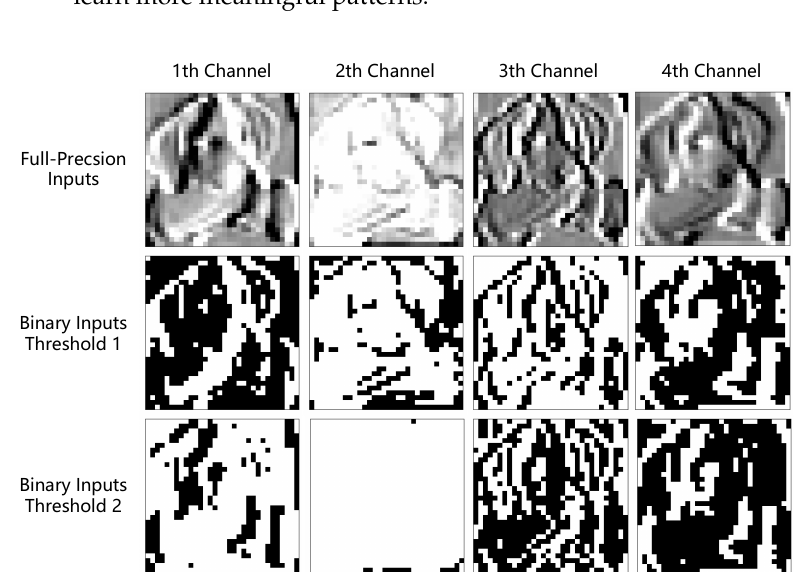
Figure 6. Visualization results of the feature maps in the first binary convolutional layer of Bi-Real+IE- BC based on ResNet-20. The rows indicate the full-precision inputs and binary inputs with different learned thresholds. The columns indicate the feature maps from the first four channels. The quality of the binary activations is measured by the visual difference between the same full-precision input and different binarized